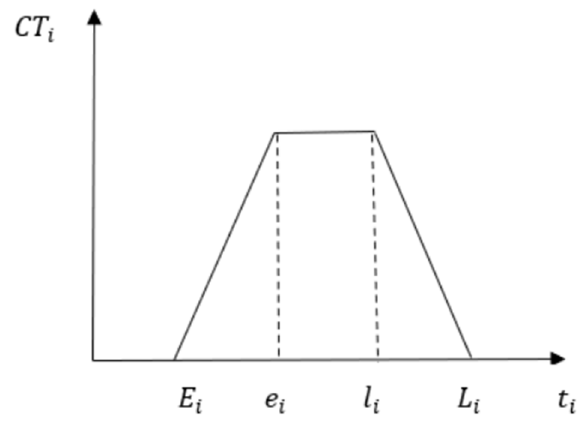
Figure 2. Customer time satisfaction.